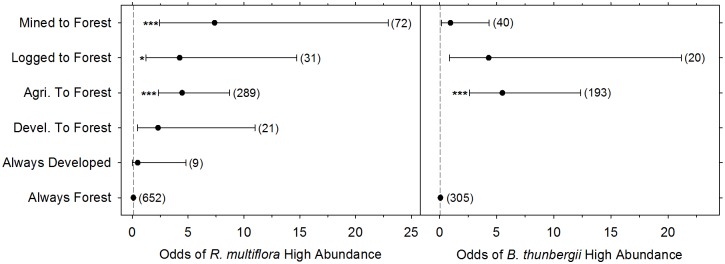
Odds of high abundance for (a) R. multiflora, (b) B. thunbergii with different land-use histories.Each point indicates the odds that each invasive species will be highly abundant (>10% cover) in a given land-use history ± 95% confidence intervals (n = 1074 plots for R. multiflora and n = 558 plots for B. thunbergii). Asterisks indicate a significant difference from always forested (i.e. forested continuously since at least 1939) plots (*p < 0.05, **p < 0.01, ***p < 0.001) and sample sizes are given in parentheses. Plots with R. multiflora or B. thunbergii cover class of 1–2 were categorized as low abundance plots and plots with cover classes of 3–6 were categorized as high abundance plots. Analysis of the always developed and developed to forest land-use categories were not complete for B. thunbergii due to small sample size.